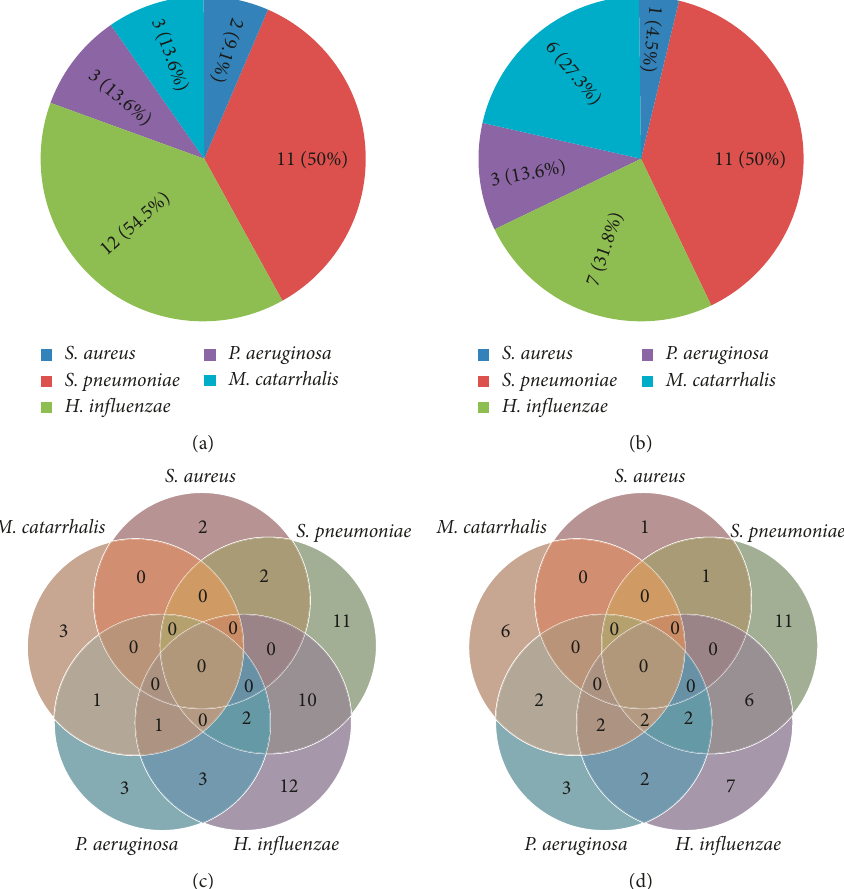
Figure 1: Bacterial detection in tonsils of patients with higher hypertrophy. The graph shows the frequency of bacterial detection in tonsils (a) and in adenoids (b). The graph shows the patients who presented bacterial codetection in the (c) tonsils and in adenoids